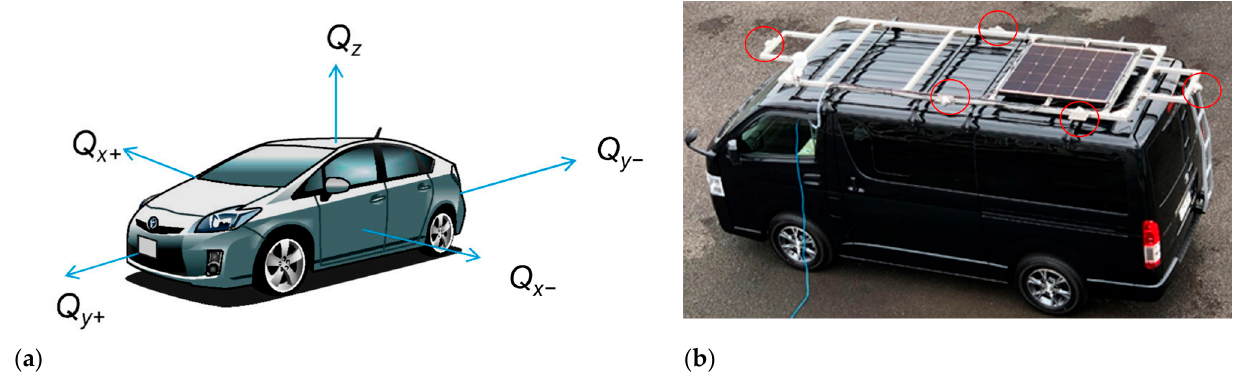
Figure 5. Multi-pyranometer irradiance measurement on the 5-axis: ( a ) de fi nition of the coordinate system; ( b ) position of the pyranometers (red circles). system; ( b ) position of the pyranometers (red